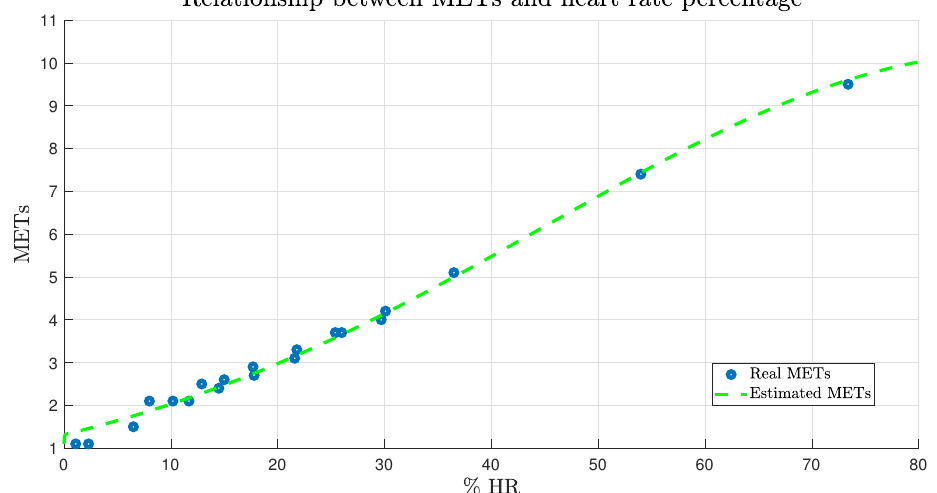
Figure 2. METs estimation based on the heart rate percentage. Graphical result between the es- timation of the relationship between METs and heart rate percentage in relation to the data of Caballero et al. [32].